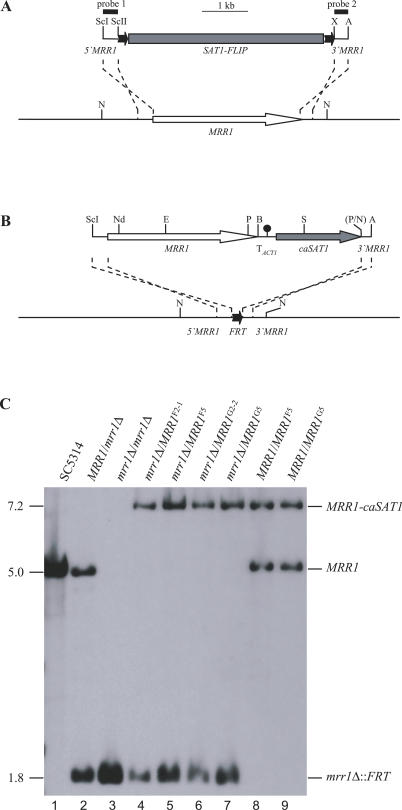
Construction of mrr1Δ Mutants and Complemented Strains(A) Structure of the deletion cassette from plasmid pZCF36M2 (top), which was used to delete the MRR1 ORF in strains SC5314, F5, G5, and CAG48B, and genomic structure of the MRR1 locus in the parental strains (bottom). The MRR1 coding region is represented by the white arrow and the upstream and downstream regions (5′MRR1 and 3′MRR1) by the solid lines. The SAT1 flipper cassette (SAT1-FLIP), in which the caFLP gene is expressed from the inducible SAP2 promoter [30], is represented by the grey rectangle bordered by FRT sites (black arrows). The 34 bp FRT sites are not drawn to scale. The probes used for Southern hybridization analysis of the mutants are indicated by the black bars.(B) Structure of the DNA fragments from plasmids pZCF36K2, pZCF36K3, pZCF36K4, and pZCF36K5 (top), which were used for integration the MRR1
F2–1, MRR1
F5, MRR1
G2–2, and MRR1
G5 alleles, respectively, into the disrupted mrr1 locus of homozygous and heterozygous mrr1Δ mutants (bottom) using the caSAT1 selection marker (grey arrow). TACT1, transcription termination sequence of the ACT1 gene.Only relevant restriction sites are given in (A) and (B): A, ApaI; B, BglII; E, EcoRI; N, NsiI; Nd, NdeI; P, PstI; S, SalI; ScI, SacI; ScII, SacII; X, XhoI. The PstI and NsiI sites shown in parenthesis were destroyed by the cloning procedure.(C) Southern hybridization of NsiI-digested genomic DNA of mrr1Δ mutants derived from strain SC5314 and of strains with reinserted MRR1 alleles with the MRR1-specific probe 1. The sizes of the hybridizing fragments (in kb) are given on the left side of the blot and their identities are indicated on the right. The genotype of the strains is given above the respective lanes. Only one of the two independently constructed series of strains is shown. Inactivation of MRR1 in the clinical isolates F5 and G5 and the reporter strain CAG48B and reinsertion of different MRR1 alleles in mrr1 mutants of the reporter strain occurred in an analogous fashion.